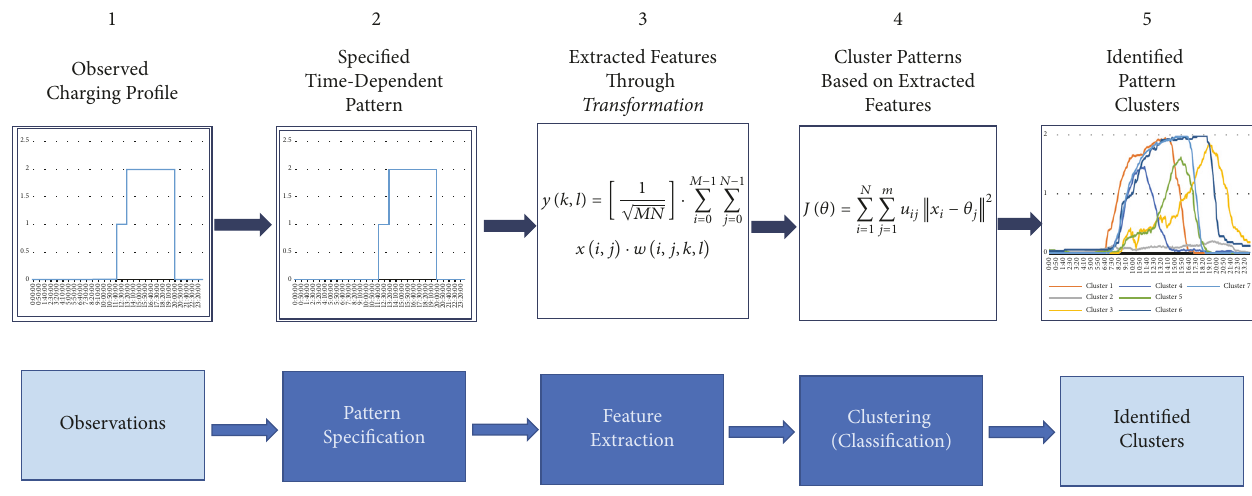
Figure 3: Methodological framework.